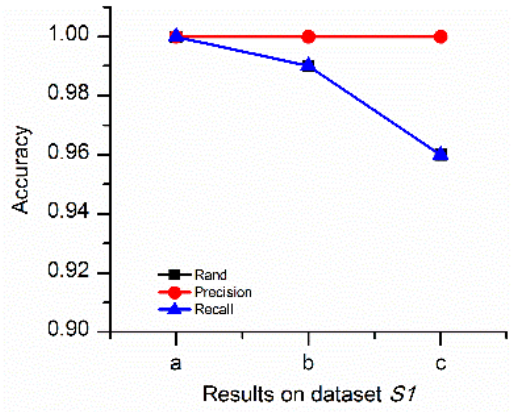
Figure 16. Accuracy values of the clustering results in Figure 15.